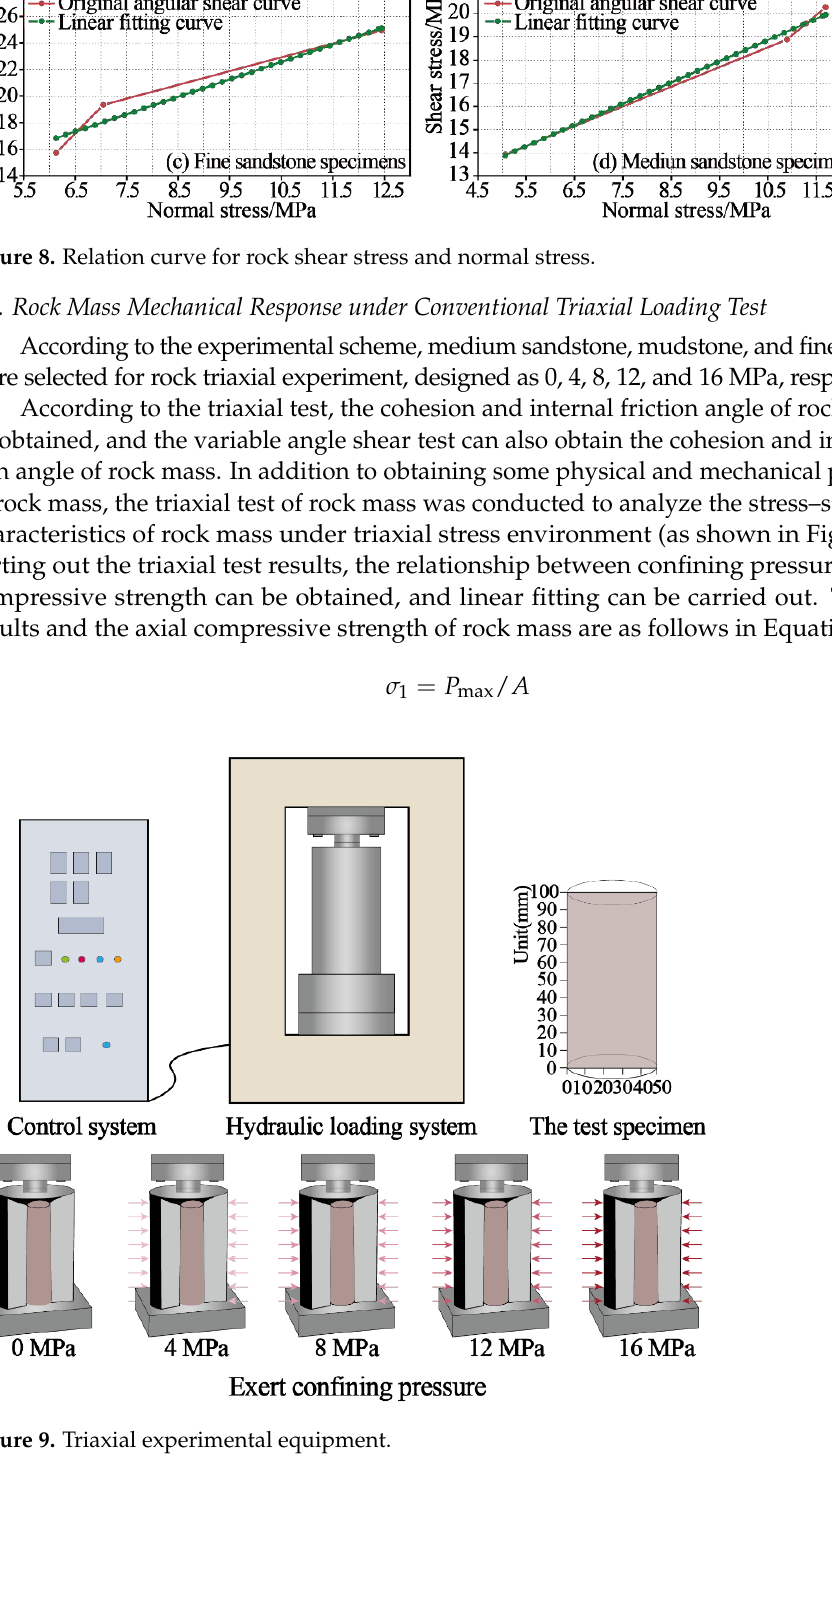
Figure 8. Relation curve for rock shear stress and normal stress.